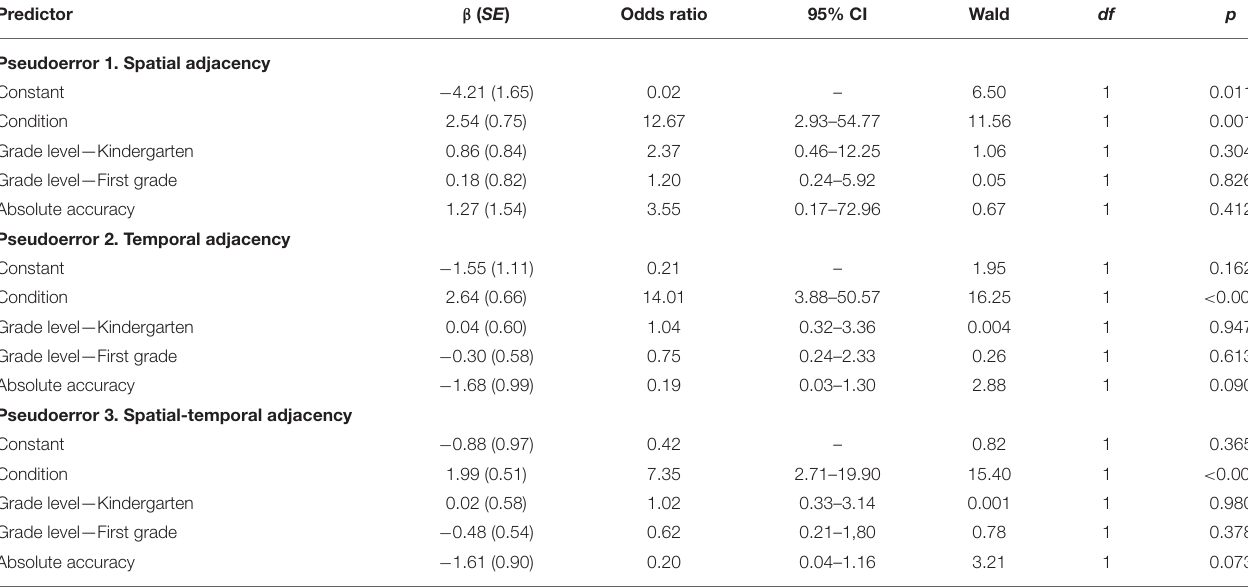
TABLE 8 | Estimated coefficients, odds ratio (OR), and statistics for predictors in binary logistic regression models. Predictor β ( SE ) Odds ratio Pseudoerror 1. Spatial